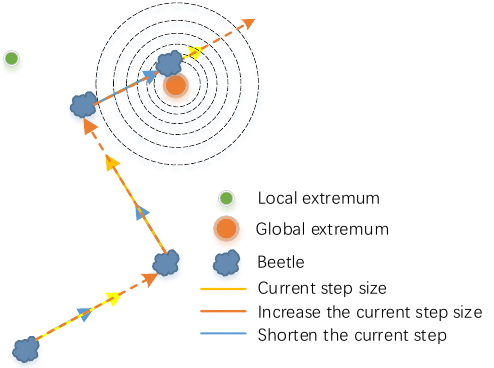
Figure 3. Schematic diagram of multi-step detection.